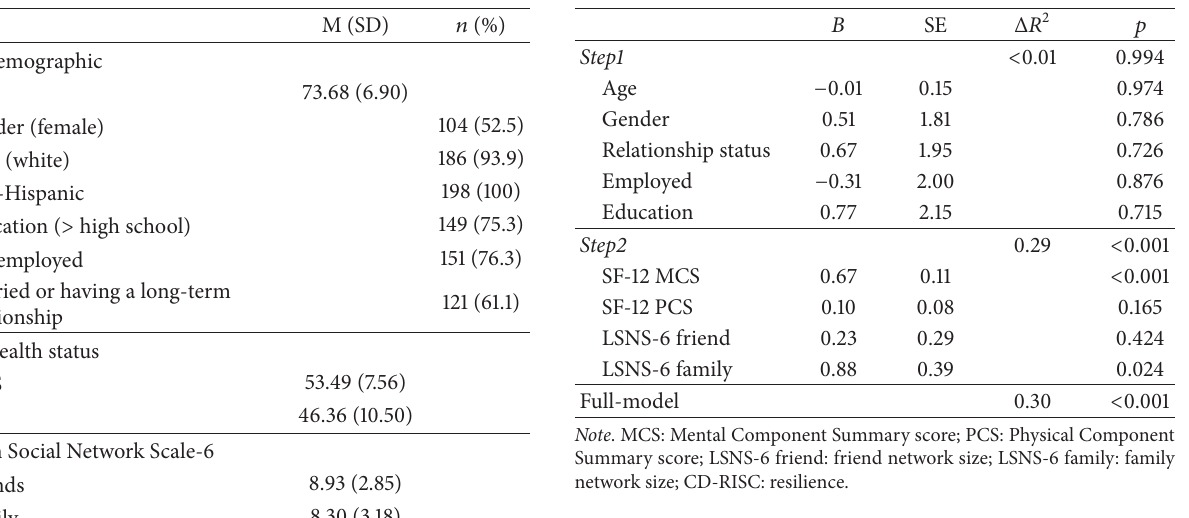
Table 1: Descriptive statistics for covariates, independent variables, and dependent variable ( 𝑁 = 198 ).